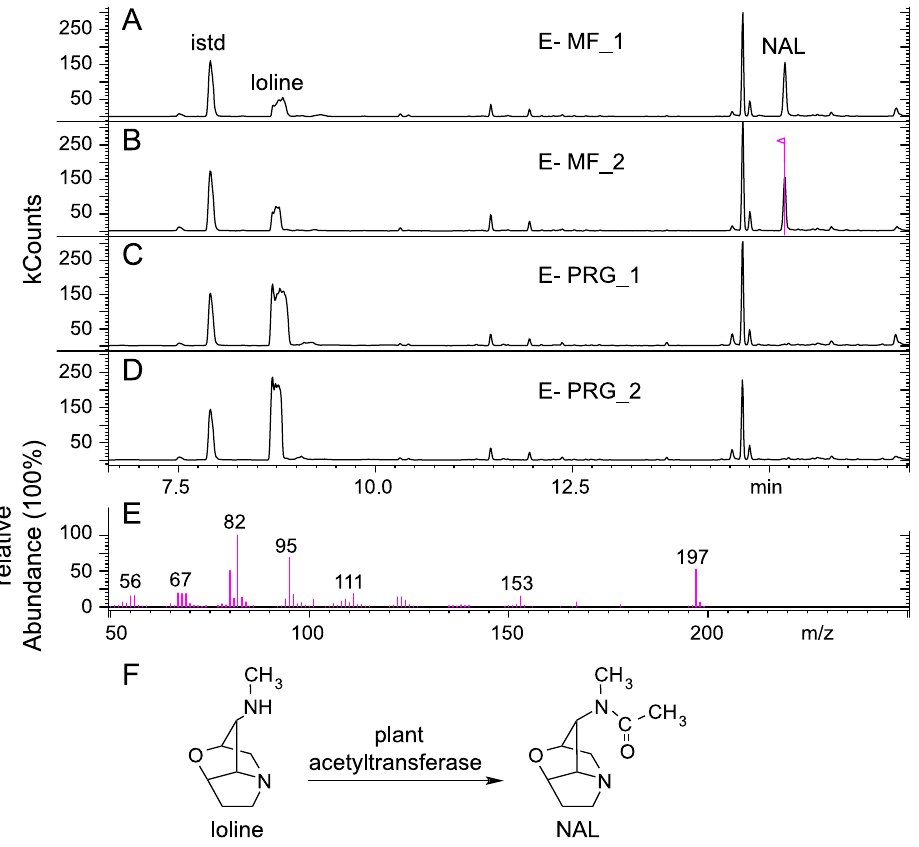
Fig. 7. GC-MS chromatogram of loline alkaloids after application of loline to asymbiotic plants. Shown are loline alkaloids extracted from loline applications to (A and B) endophyte-free (E-) meadow fescue (MF), and (C and D) E- perennial ryegrass (PRG), (E) mass spectrum of N -acetylloline (NAL) from application of loline to E- meadow fescue, and (F) proposed scheme of NAL formation from loline. Quinoline was added as internal standard (istd). Unlabeled peaks are non-loline alkaloid compounds. Numbers after MF or PRG indicate independent trials.